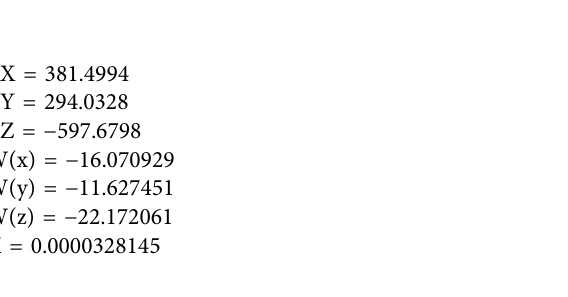
Frontiers in Earth Science |